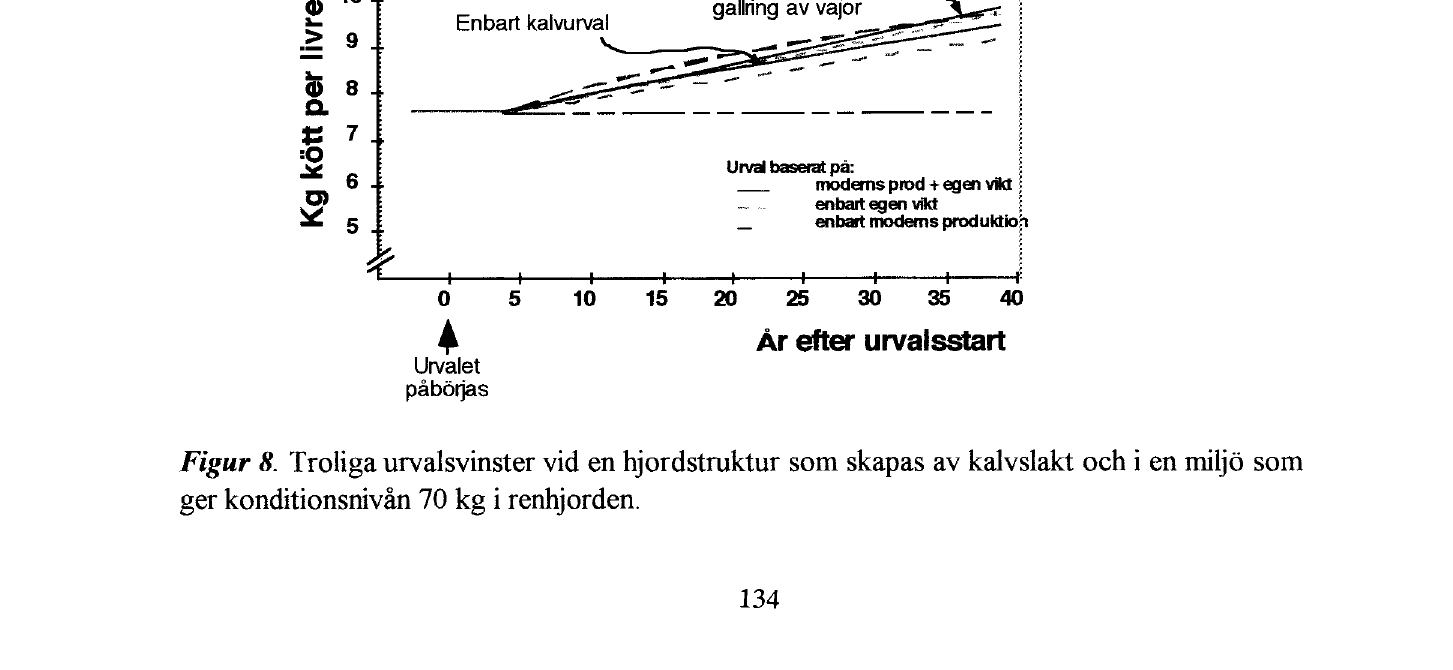
Figur 8. Troliga urvalsvinster vid en hjordstruktur som skapas av kalvslakt och i en miljo som ger konditionsnivån 70 kg i